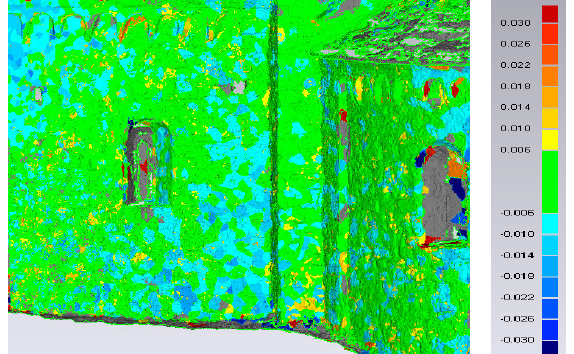
Fig. 7. Original images, orientation results and 3D point cloud from dense matching (ca 4 million points).